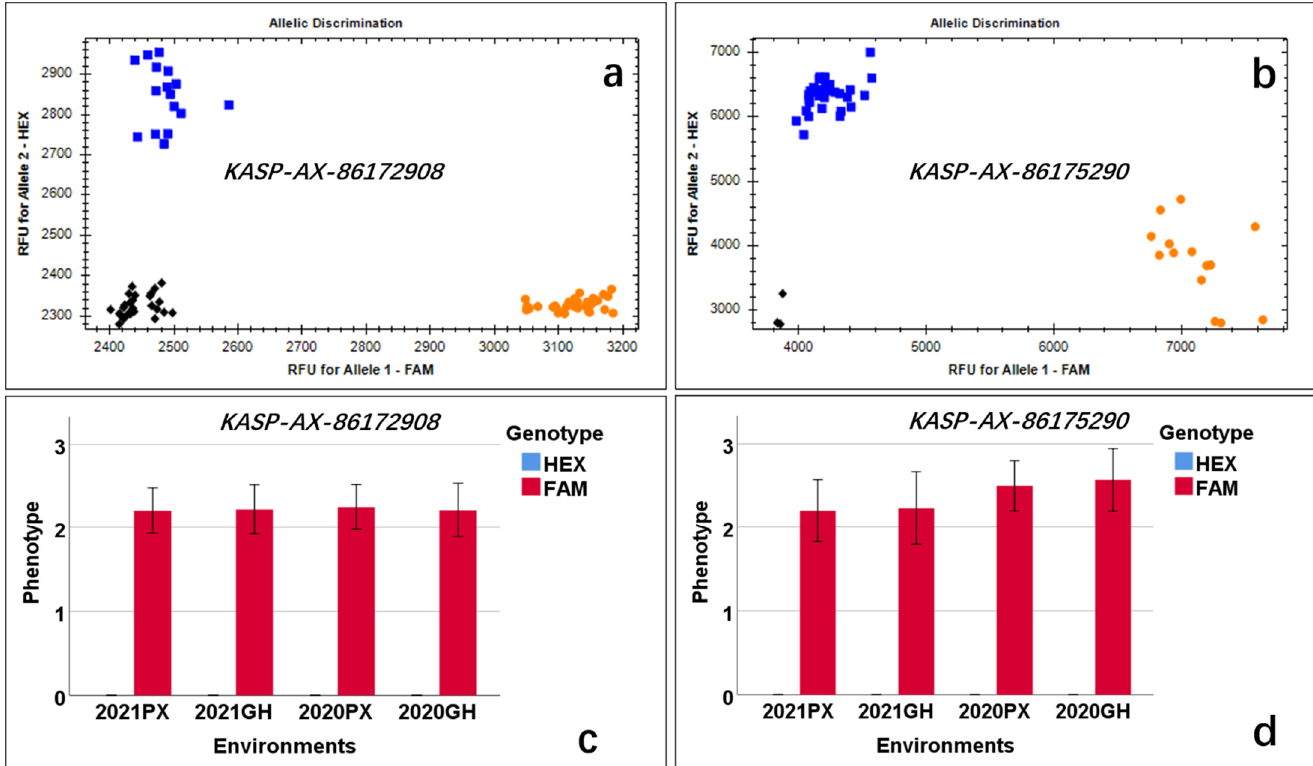
Figure 3. Physical map and candidate genes of the major-effect QTL QLp.saas-7BS in relation to the Chinese Spring, wild emmer, and durum wheat reference genome sequences accessed in the Triticeae Multi-omics Center database (http://202.194.139.32/).